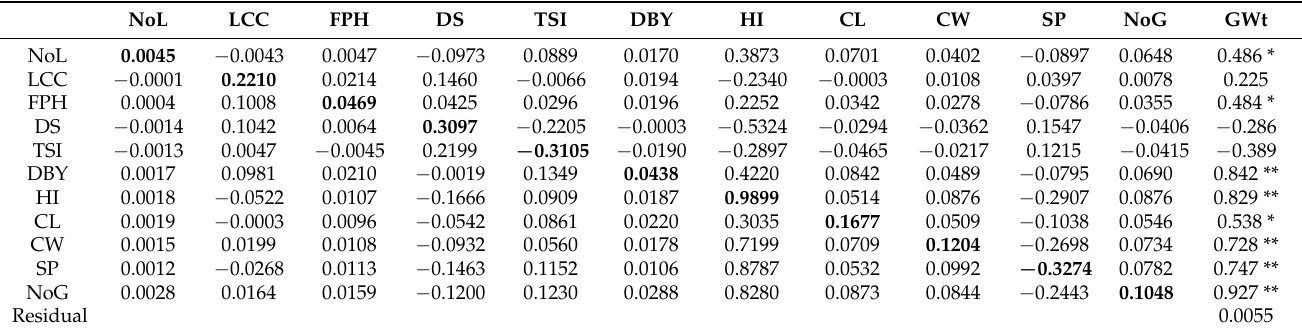
Table 5. Direct (bold diagonal) and indirect effects of selected maize growth and yield traits on grain weight under heat- and water-stress (CHWS)